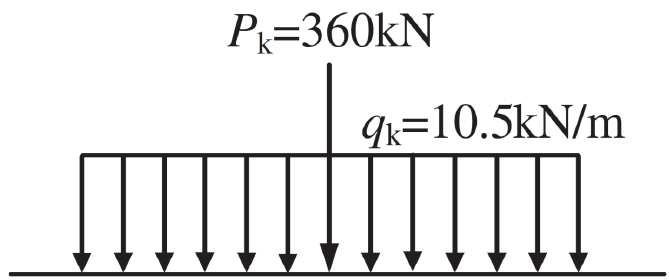
Figure 4. The grade-I lane load of the